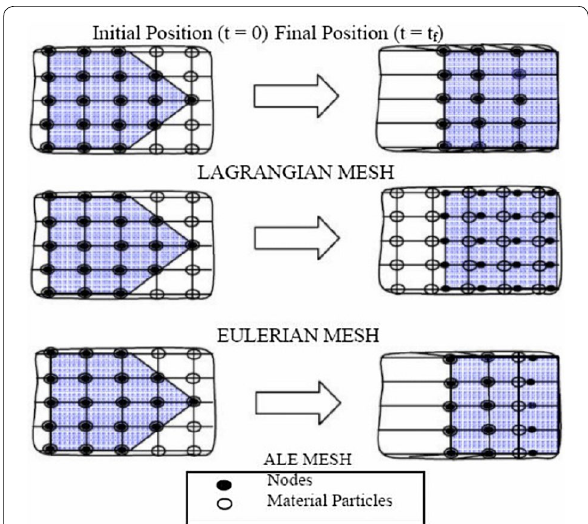
Figure 4 Description of each mesh modeling method [24]